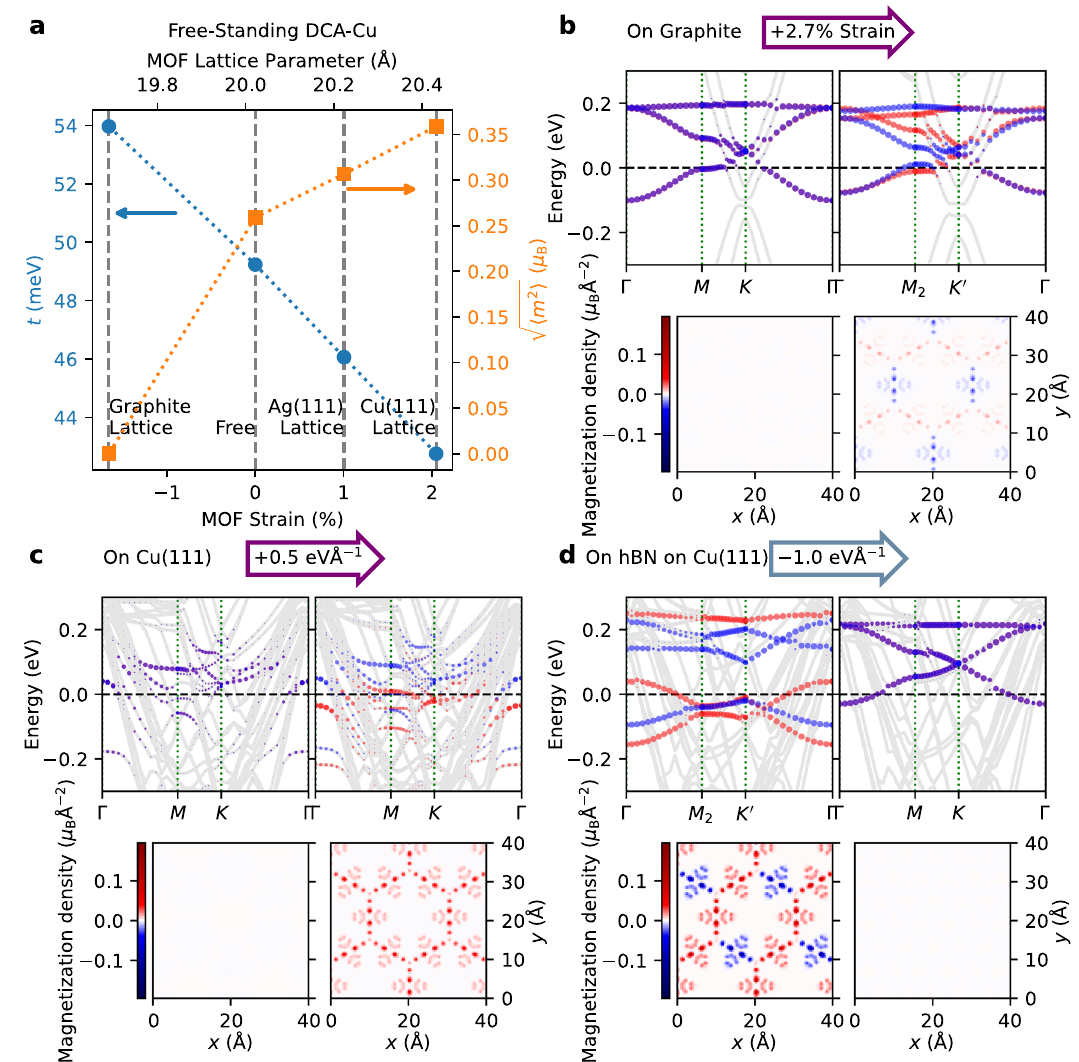
Fig. 6 Tailoring magnetism in DCA-Cu on substrates by strain and electric fi elds. a Variation of hopping constants and local magnetic moments of free-standing DCA-Cu due to strain. Vertical lines mark lattice constants of different substrate supercells for reference, although these DFT calculations do not include substrates. b Band structure and magnetisation density of DCA-Cu on graphite before and after applying strain. c Band structure and magnetisation density of DCA-Cu on Cu(111) before and after applying an electric fi eld normal to the plane pointed towards the substrate, increasing electron fi lling. d Band structure and magnetisation density of DCA-Cu on hBN on Cu(111) before and after applying an electric fi eld in the opposite direction, decreasing electron fi lling. Legends in b – d have the same meaning as in Fig. 2. Purple circles are spin